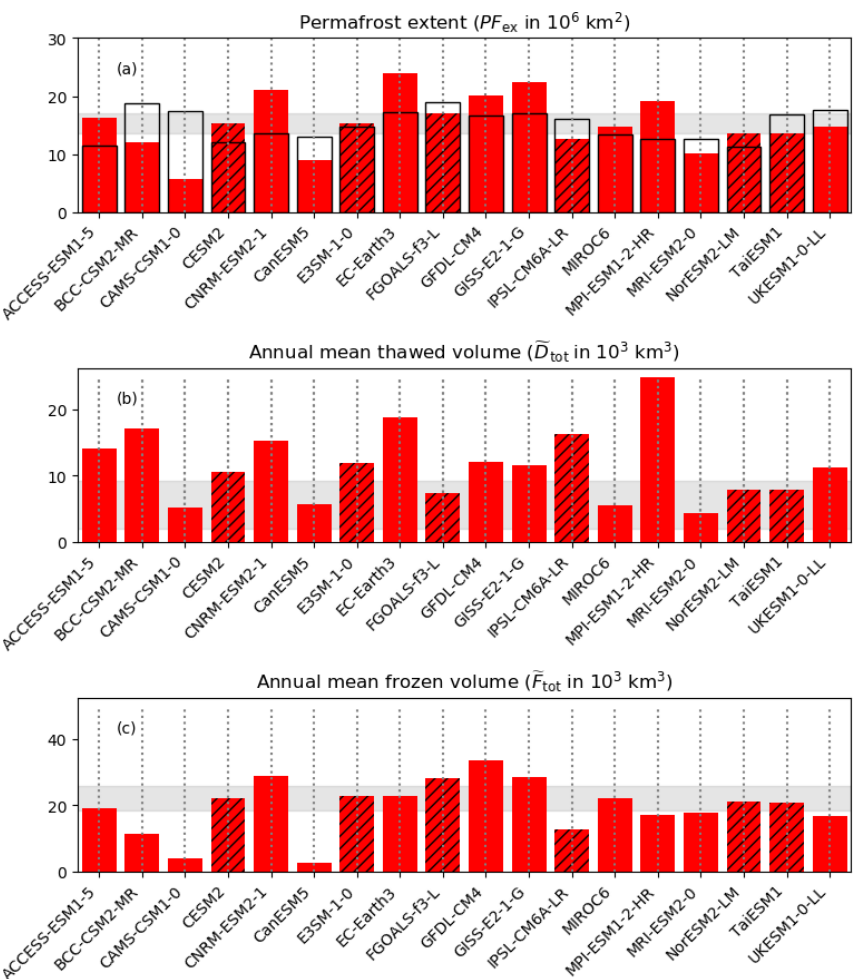
Figure 11. (a) Modelled permafrost extent; (b) annual thawed volume ( (cid:101) D tot ); and (c) and annual frozen volume ( (cid:101) F tot ) of the top 2m soil for different CMIP6 models for the climatological period of 1995–2014. Permafrost extents (PF ex ) derived using the mean temperature at D zaa are the red with black hatching, and those derived using mean temperature at the bottom of the modelled soil profile are in red without hatching. The empty bars with black outlines are the PF benchmark derived from the relationship of Chadburn et al. (2017). The grey shaded area is the range expected from